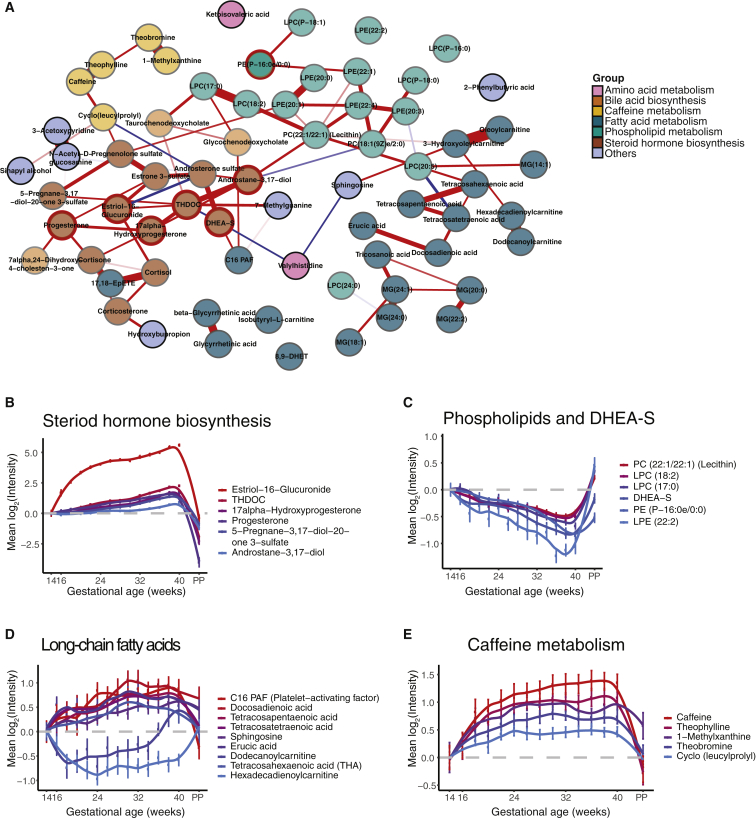
Functional Metabolite Groups Altered during Pregnancy(A) Regularized partial correlation network of top altered compounds in pregnancy. Here, each node represents a compound, and each edge represents the strength of partial correlation between two compounds after conditioning on all other compounds in the datasets. Edge weights represent the partial correlation coefficients. Note that the seven nodes with red circles with central positions were also the predictors in the models of Figures 4 and 5.(B–E) The average levels of the metabolite changes against the gestational progression in the clusters of steroid hormone biosynthesis (B), phospholipids and DHEA-S (C), long-chain fatty acids (D), and caffeine metabolism (E). The intensities were normalized to the baseline, which was defined by averaging all samples before 14 weeks. The standard errors, derived from 30 subjects, are shown. The GAs were standardized by scaling delivery events to 40 weeks. Abbreviation is as follows: PP, postpartum. Note that the y axis scale is much larger for steroids than for other compounds.See also Figure S2.